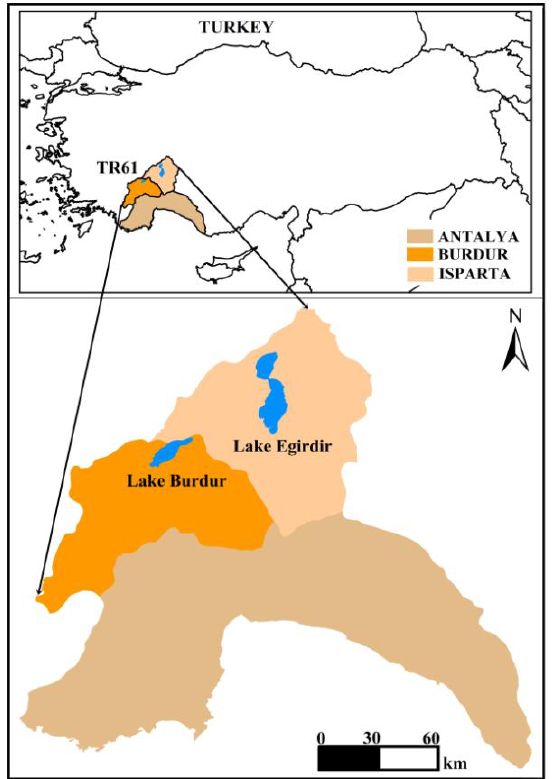
Figure 1. The locations of Burdur and Egirdir Lakes in West Mediterranean Region (TR61) of Turkey.